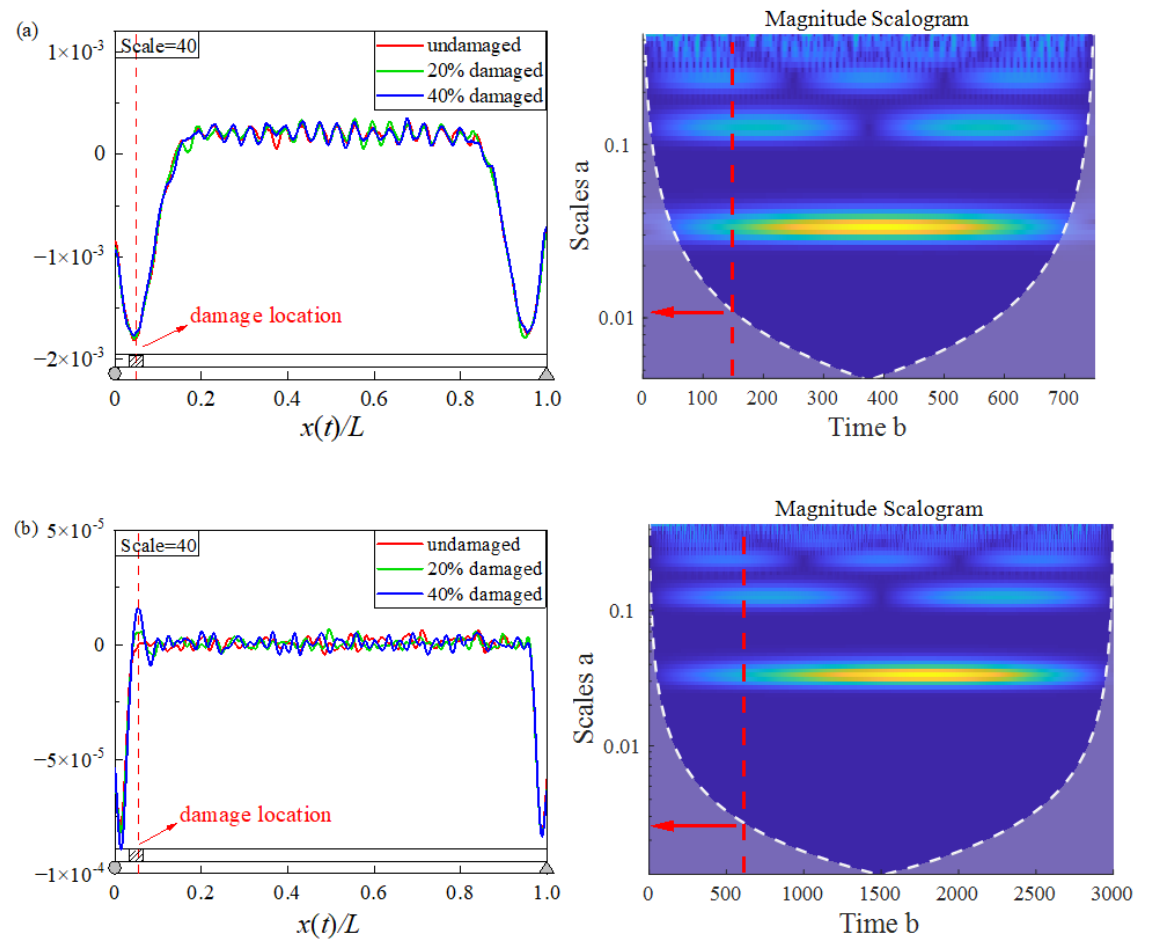
Figure 14. CWC and influence cone at different speeds: ( a ) 4 m/s; ( b ) 1